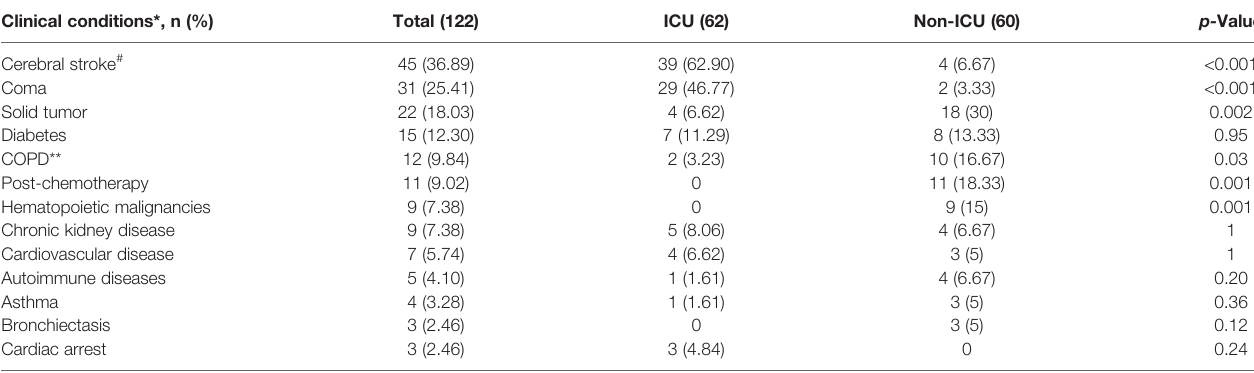
TABLE 2 | Clinical conditions of